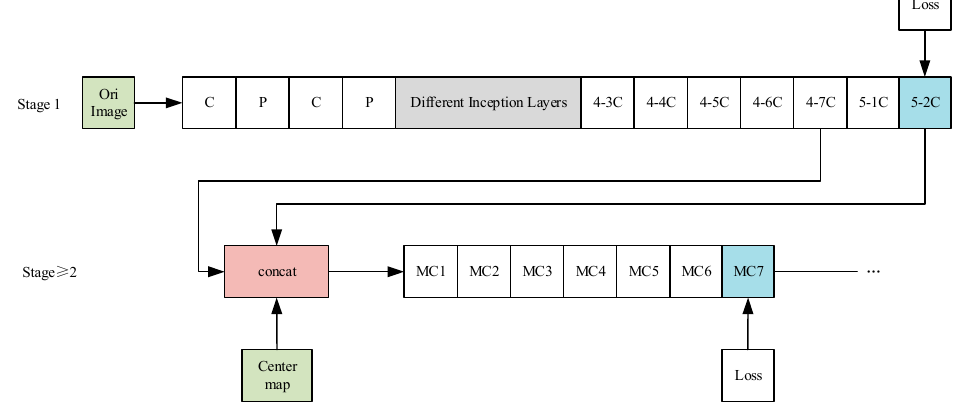
Figure 4. The overall structure of the improved models.